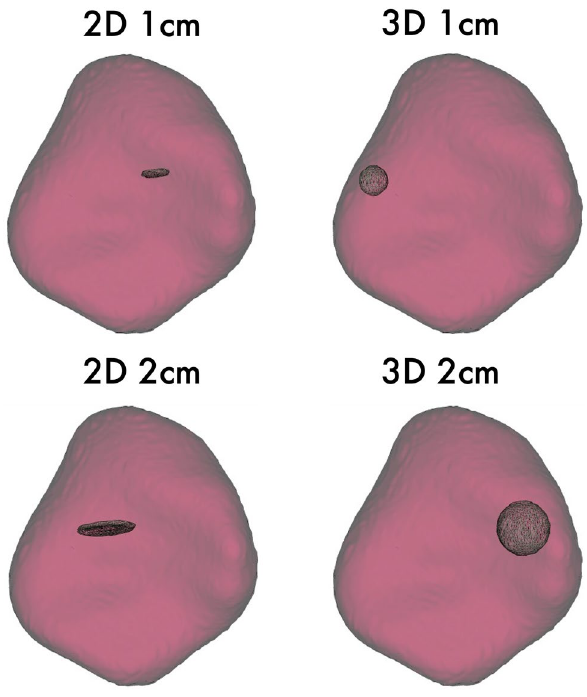
Figure 2. Example segmentations in a spleen with 1 cm and 2 cm maximum diameter in 2D and